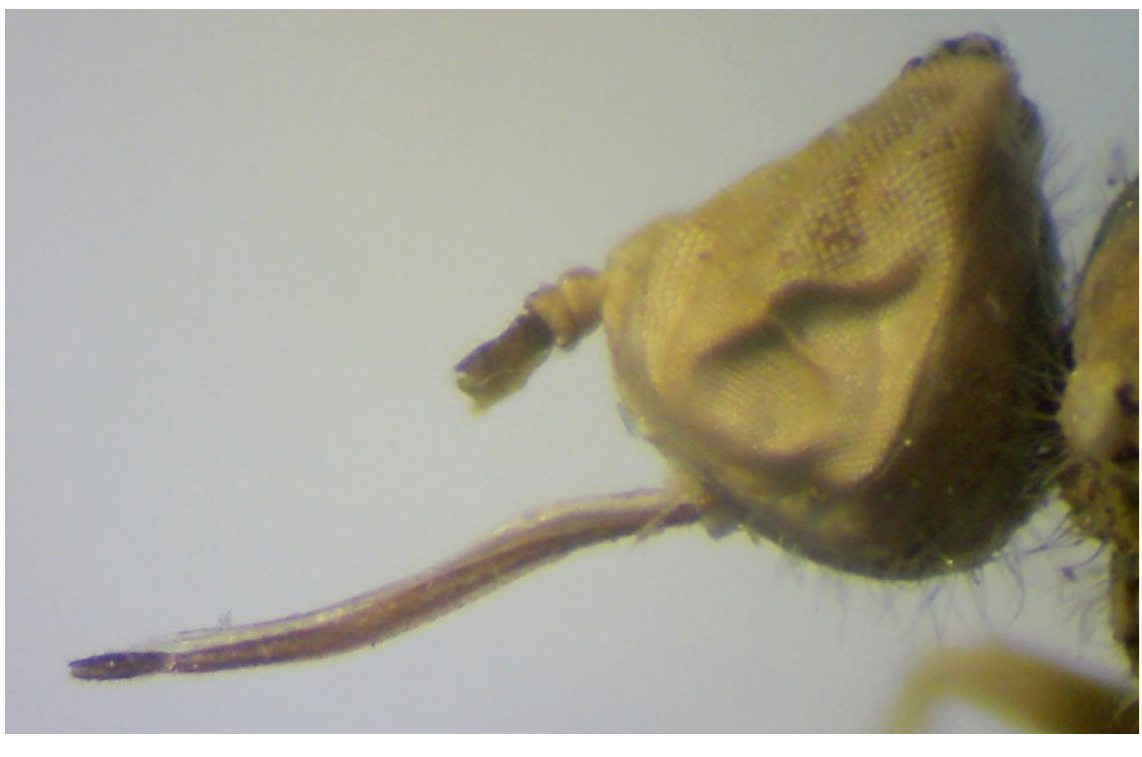
Fig. 1. Parageron lutescens (Bezzi, 1925), ♂.